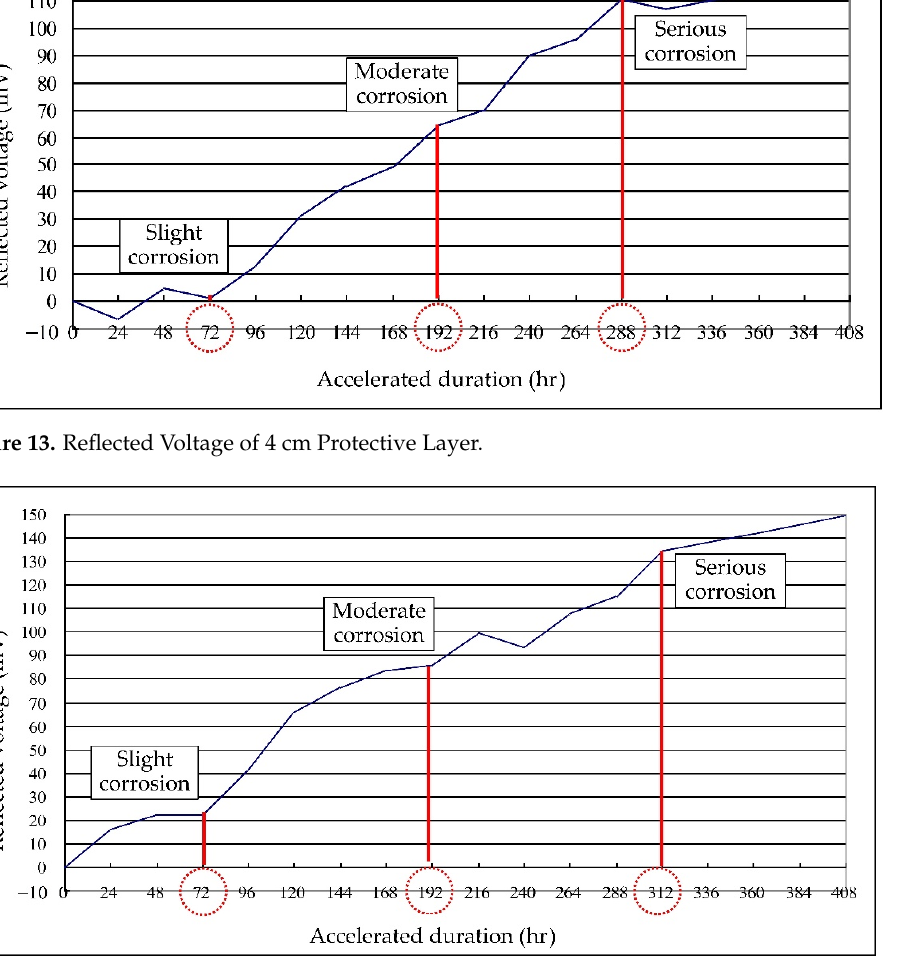
Figure 14. Reflected Voltage of 6 cm Protective Layer.